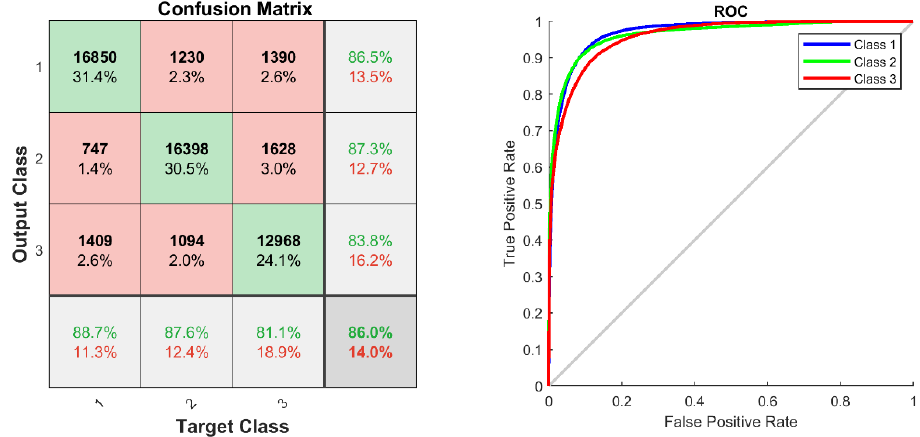
Figure 10. Confusion matrix ( left ) and ROC curve ( right ) of classifier for subject 3 on test data.